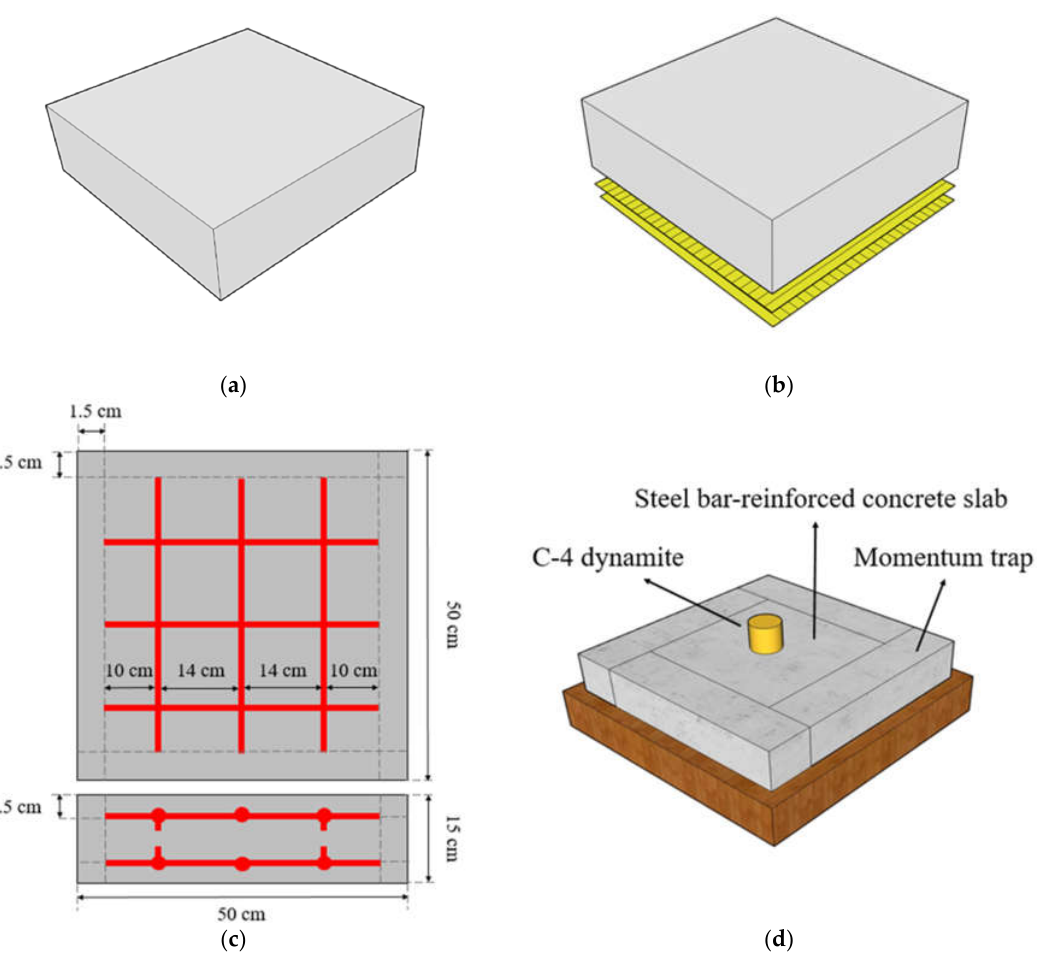
Figure 2. Illustration and configurations of KFRC slab and momentum traps: ( a ) KFRC slab; ( b ) KFRC slab with KFRP; ( c ) the rebar reinforcement configuration in slab; ( d ) KFRC slab with momentum traps under C-4 dynamite.